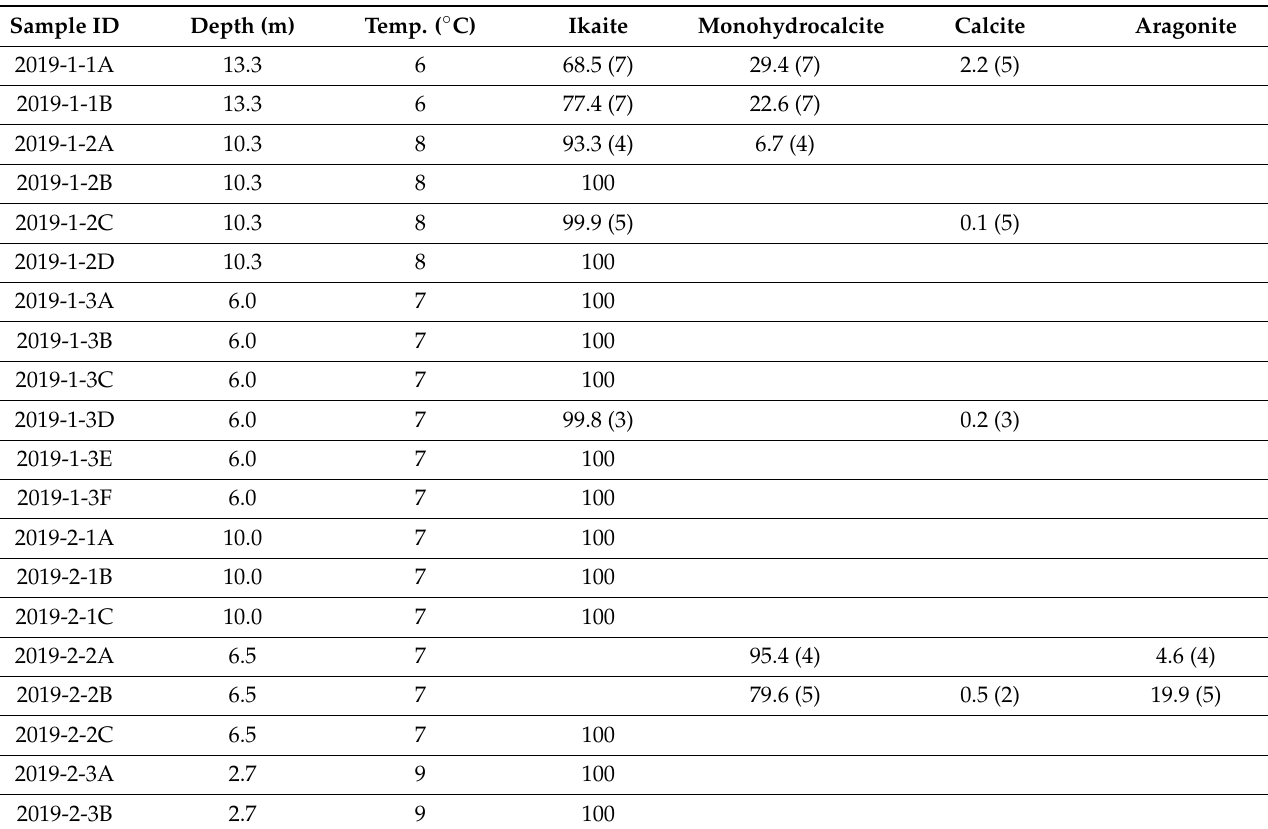
Table 1. XRD Results of tufa column samples from Ikka Fjord *. Relative proportions in